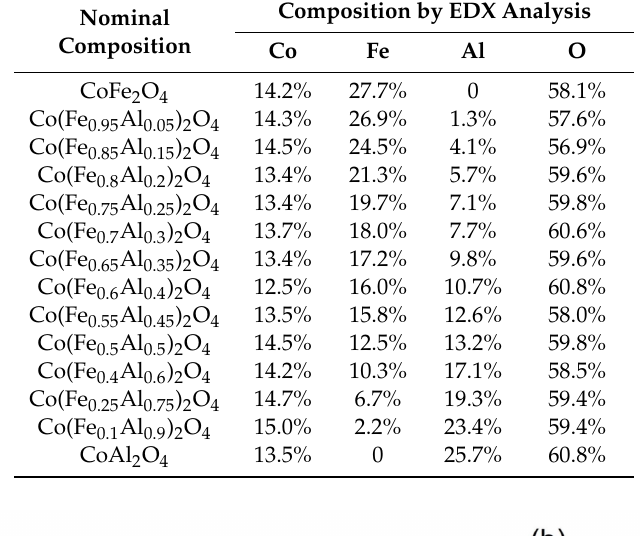
Table 1. The nominal composition and the elemental content detected from the EDX.